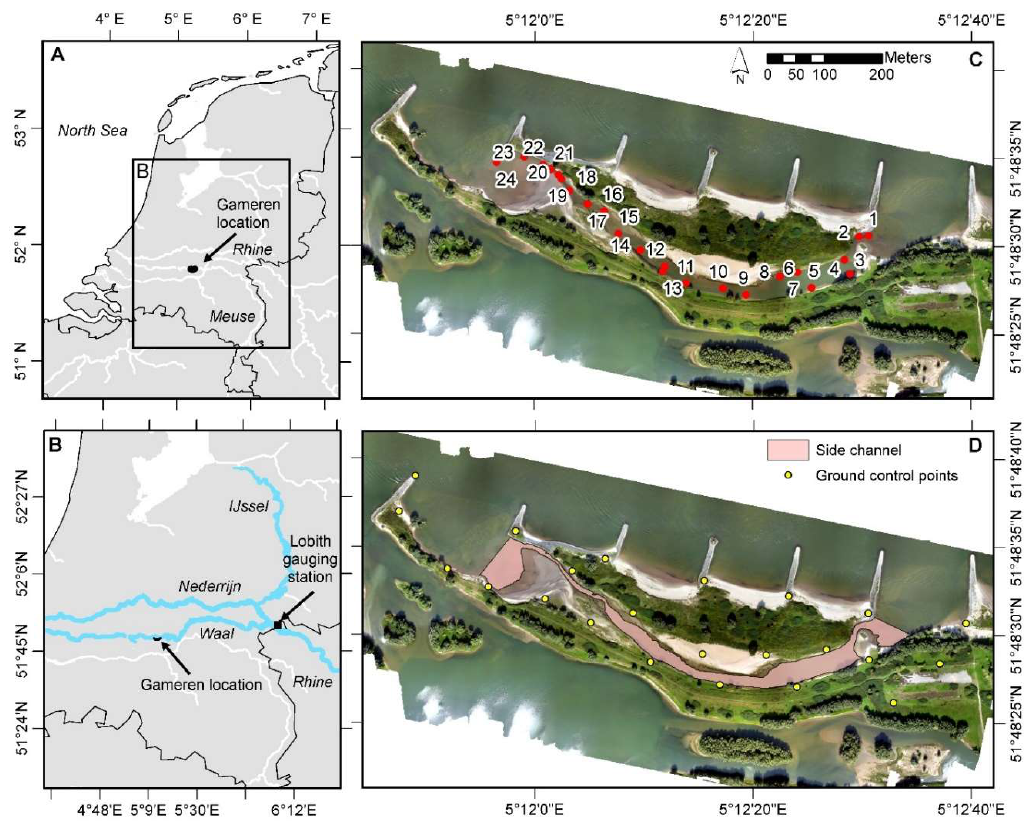
Figure 2. ( a ) Location of the study area in the Netherlands, ( b ) river Rhine tributaries in blue, with study area along the river Waal, ( c ) Aerial photo of the northern side channel and groyne fields with in-situ water temperature locations (red dots), ( d ) Side channel subsection of study area used for assessment of heterogeneity in water temperature.